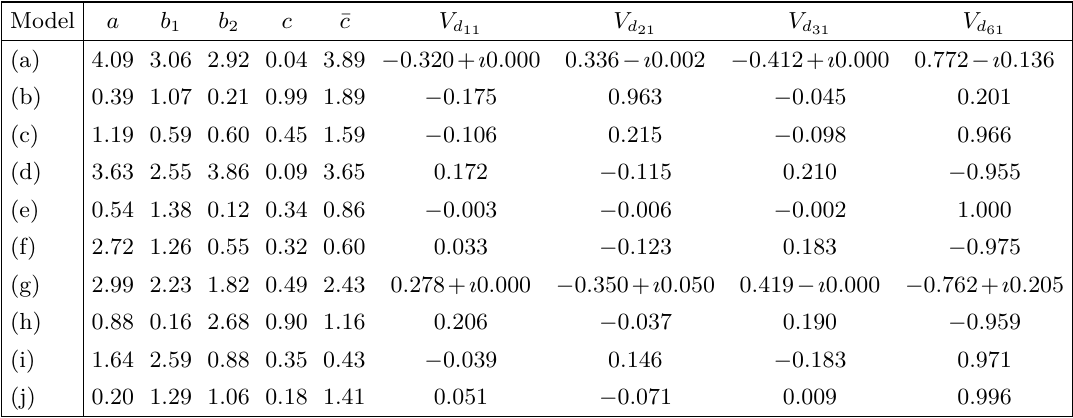
Table 3 . A numerical estimate of the elements of the up Higgs zero mode eigenvector using the analysis of table 1 and the couplings of eq. (2.2).